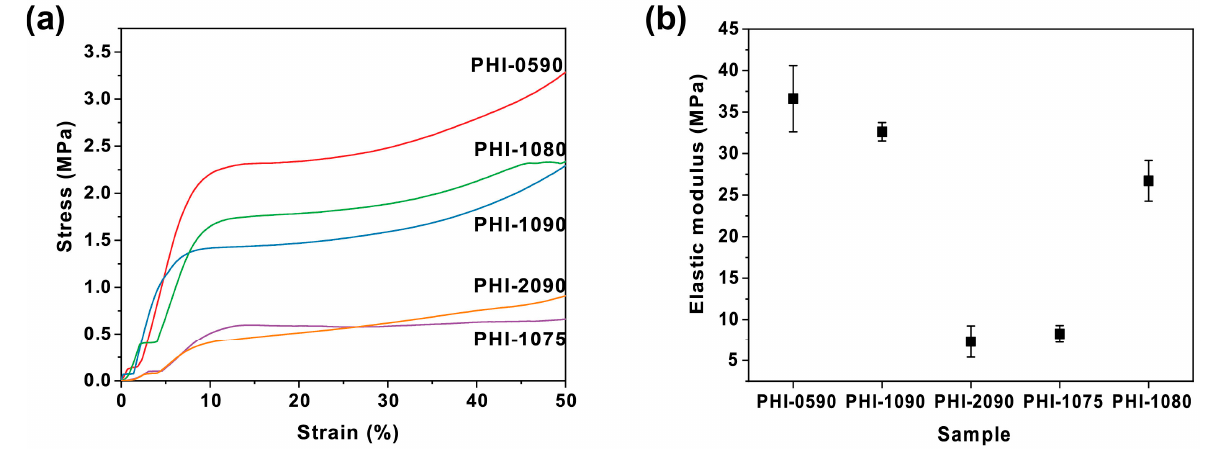
Figure 2. Stress–strain curves ( a ) and Young’s modulus ( b ) of the varied polyHIPE scaffolds under compressive load.